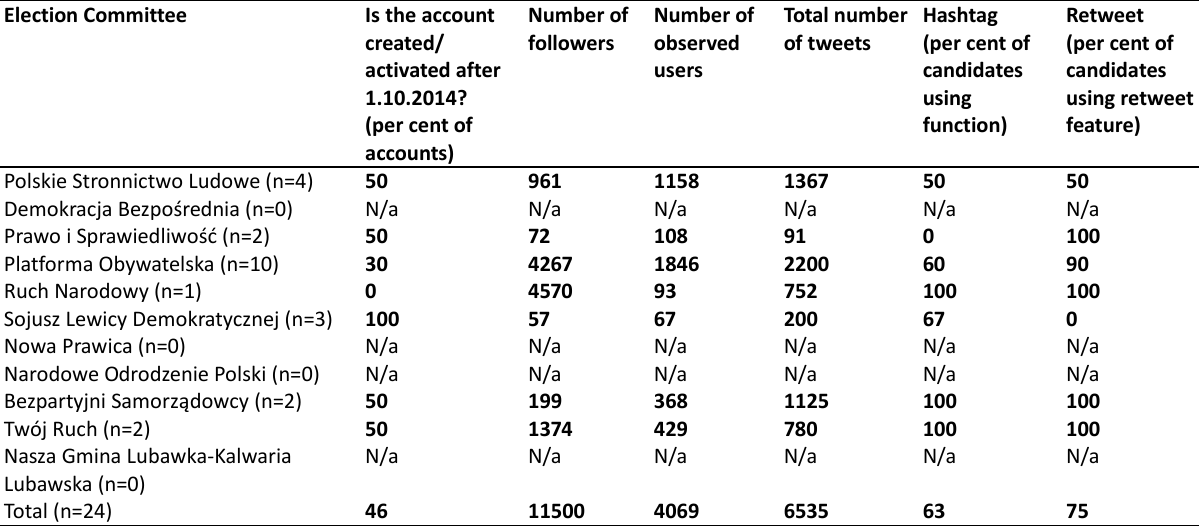
Table 5. Lower Silesia Regional Assembly candidates on